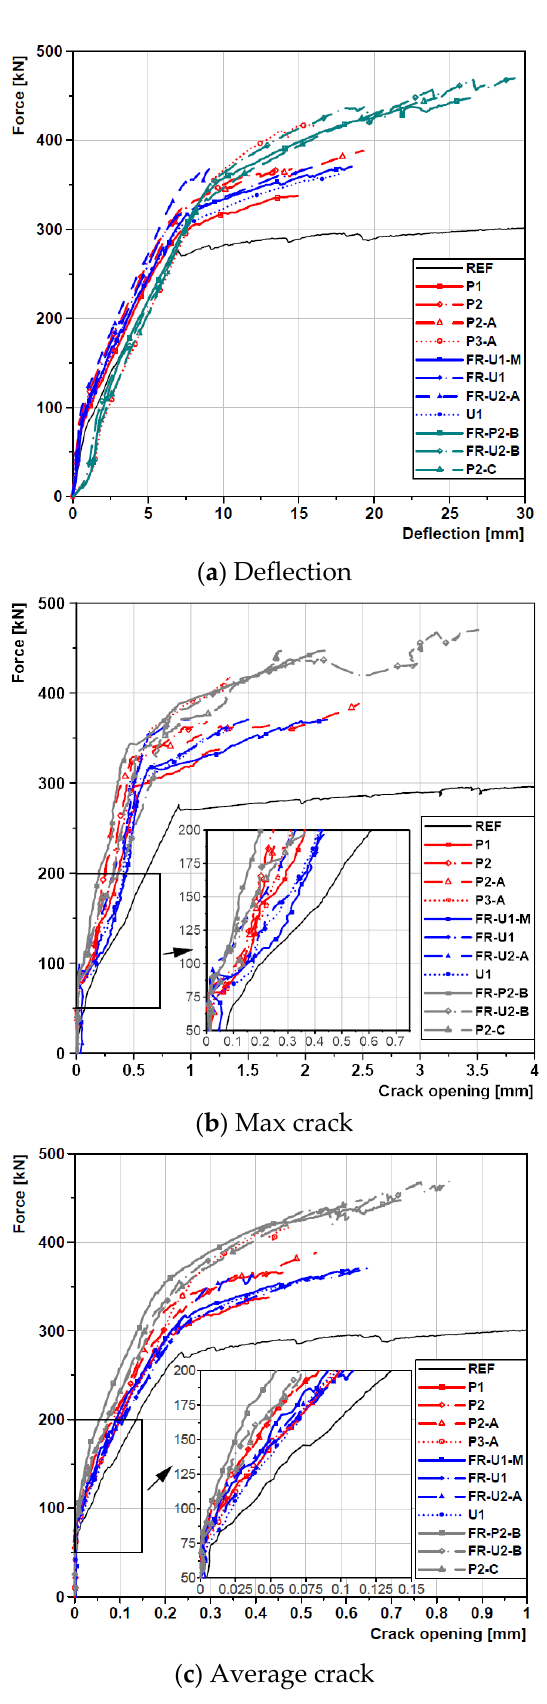
Figure 5. Force—Deflection/Crack Opening curves. In terms of crack control capability of the strengthening solutions, all beams show the effectiveness of such type of subsequently attached F/TRC layers. In detail, however,